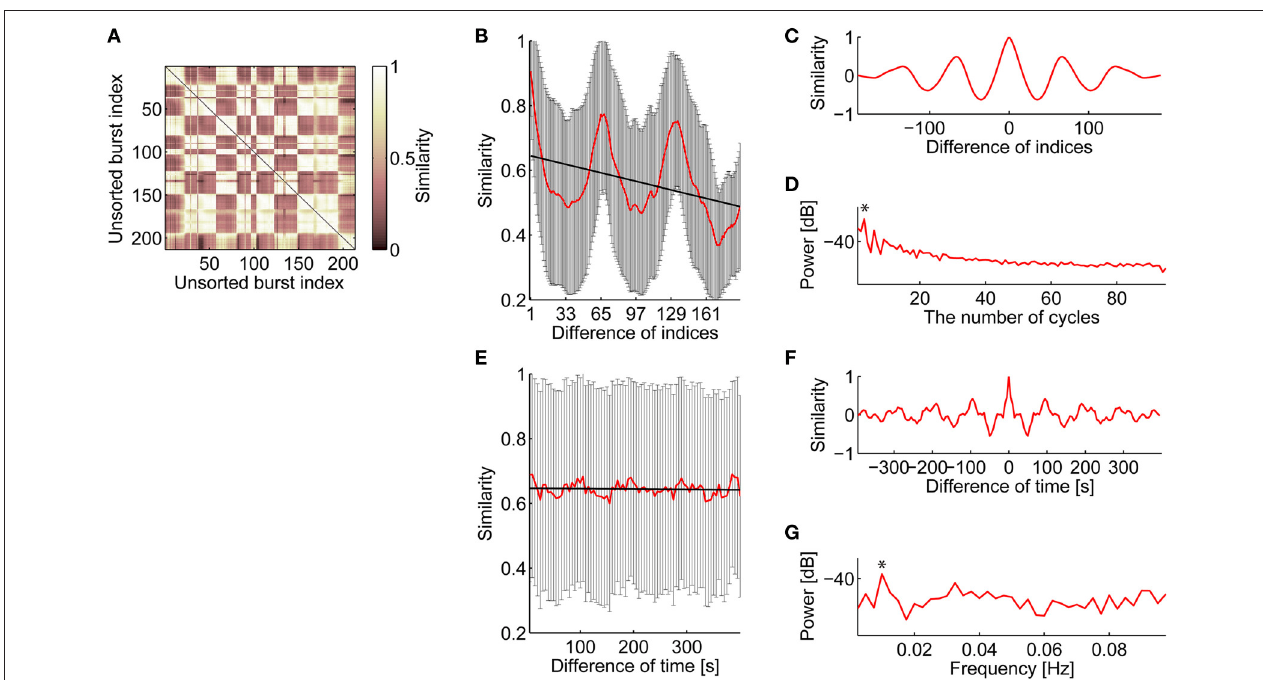
FIGURE 5 | Consecutive and periodic appearance of similar spatiotemporal patterns of bursts. (A) Similarity matrix of bursts. Bursts are listed in temporal order. (B) Relationship between similarity and the difference of the burst indices in temporal order. The red line indicates mean similarity against the difference of burst indices in temporal order. The error bars are SD. The thick black line is a linear regression line to the mean similarity. (C) Autocorrelation of the mean similarity that subtracted the regression line shown in (B) . (D) Periodogram of the mean similarity that subtracted the regression line. Asterisk indicates a maximum peak. The significance level of the maximum peak was tested using Fisher’s g-statistic. (E–G) , The same analysis as shown in (B – D) , respectively, about relationship between similarity and the difference of burst appearance